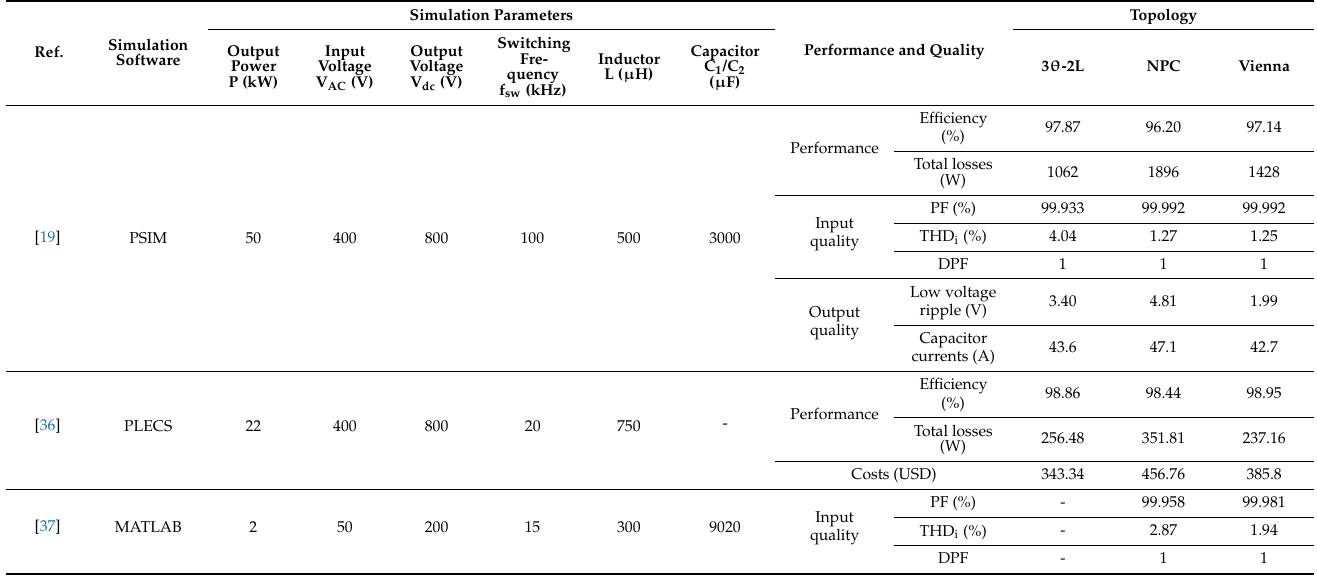
Table 3. Comparison table for DC-AC converter topologies.